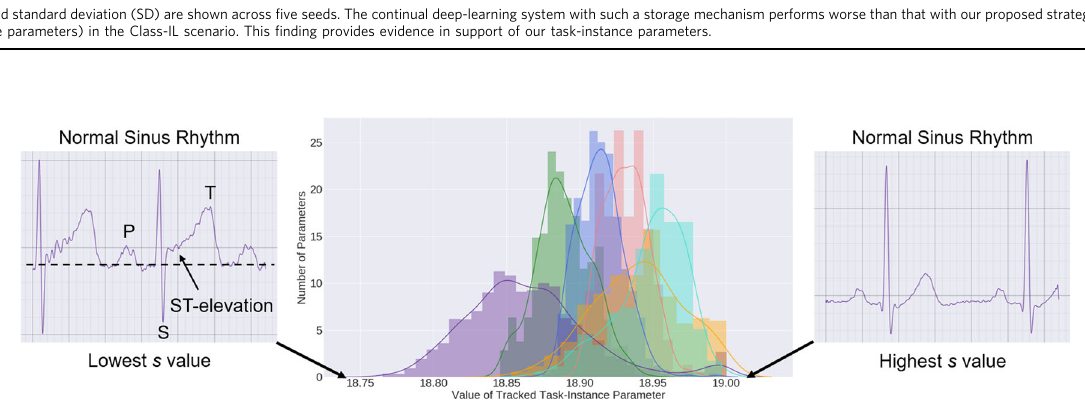
Fig. 4 Distribution of the storage parameter values, s , learned by the deep-learning system in the Class-IL scenario. The storage and acquisition fractions are b = 0.25 and a = 0.50, respectively, and each color corresponds to a different task. Based on our interpretation of storage parameters as a proxy for instance dif fi culty, we selected two ECG recordings associated with the lowest (most dif fi cult) and highest (least dif fi cult) s values. The ECG recording deemed most dif fi cult by the deep-learning system had a ground-truth cardiologist-derived label of normal sinus rhythm. However, the presence of ST-elevation, a feature typical in an abnormal condition known as myocardial infarction, could have been a source of confusion for the deep-learning system and hindered its ability to correctly diagnose this ECG